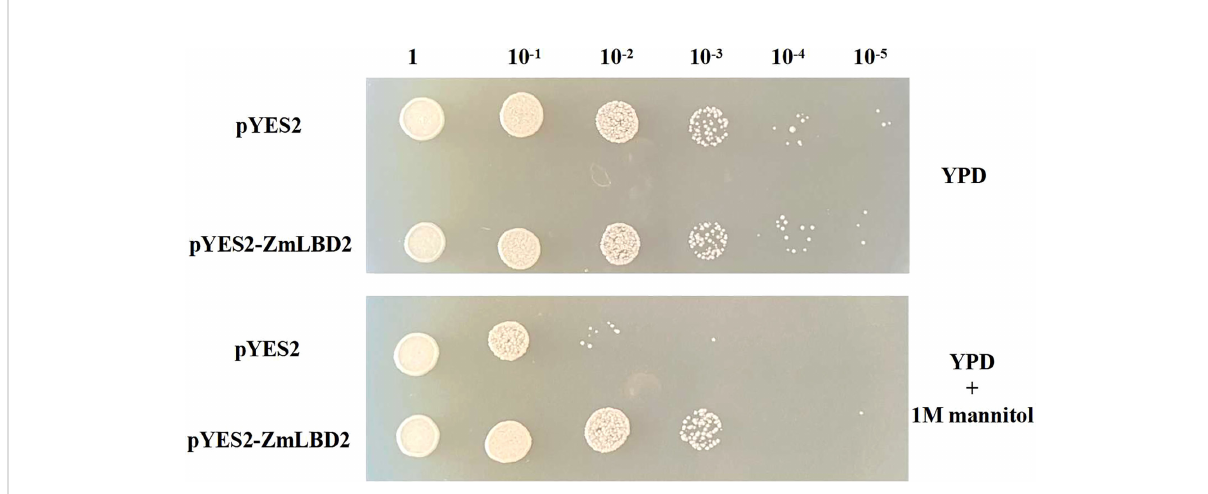
FIGURE 6 Phenotypic analysis of ZmLBD2 transgenic yeast strains under mannitol stress.